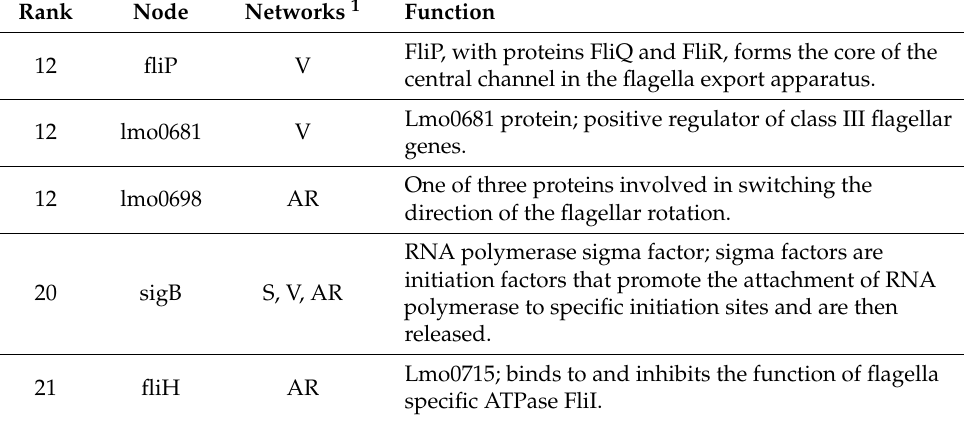
Table A8. STRING functional enrichment analysis for top 21 nodes for the combined